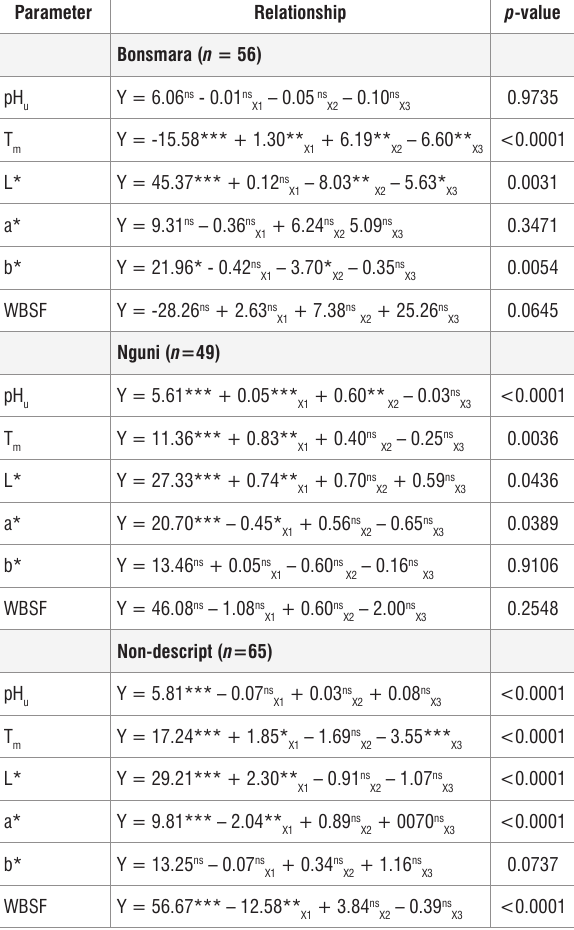
Table 2: Linear relationships between pre-slaughter conditions (distance travelled, lairage duration and ambient temperature) and beef quality characteristics by genotype